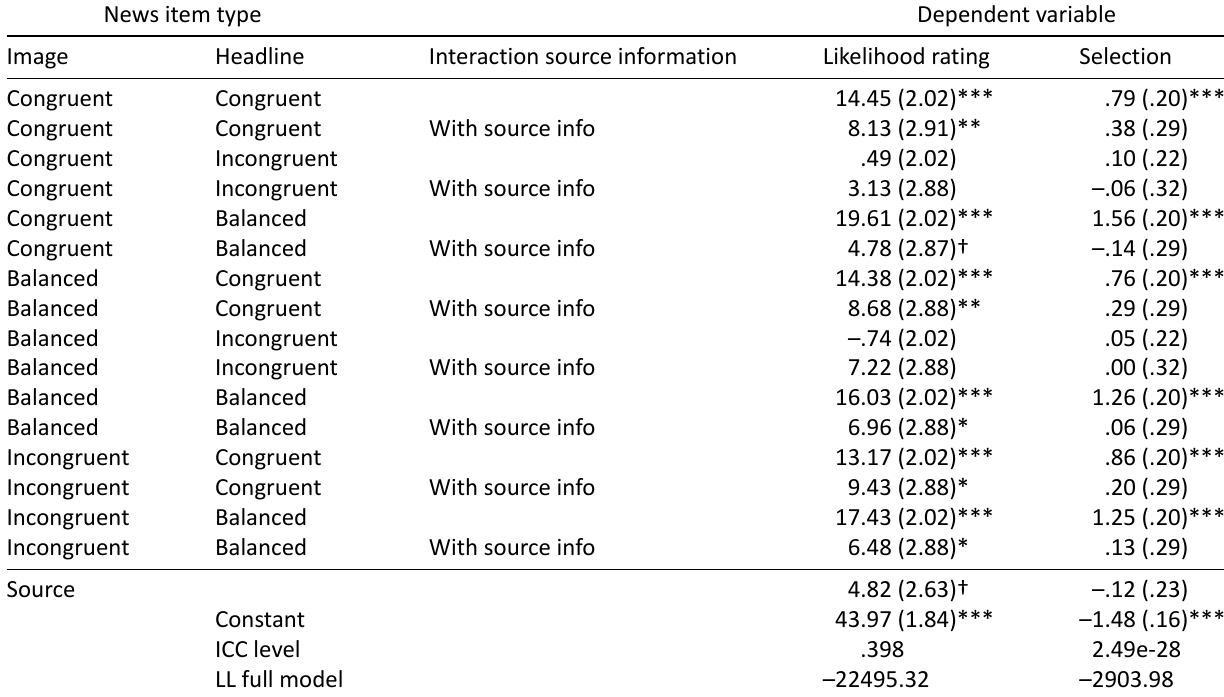
Table B3. Gun ownership context, multilevel models explaining peoples’ likelihood of viewing and selection of a news items, interacted with source